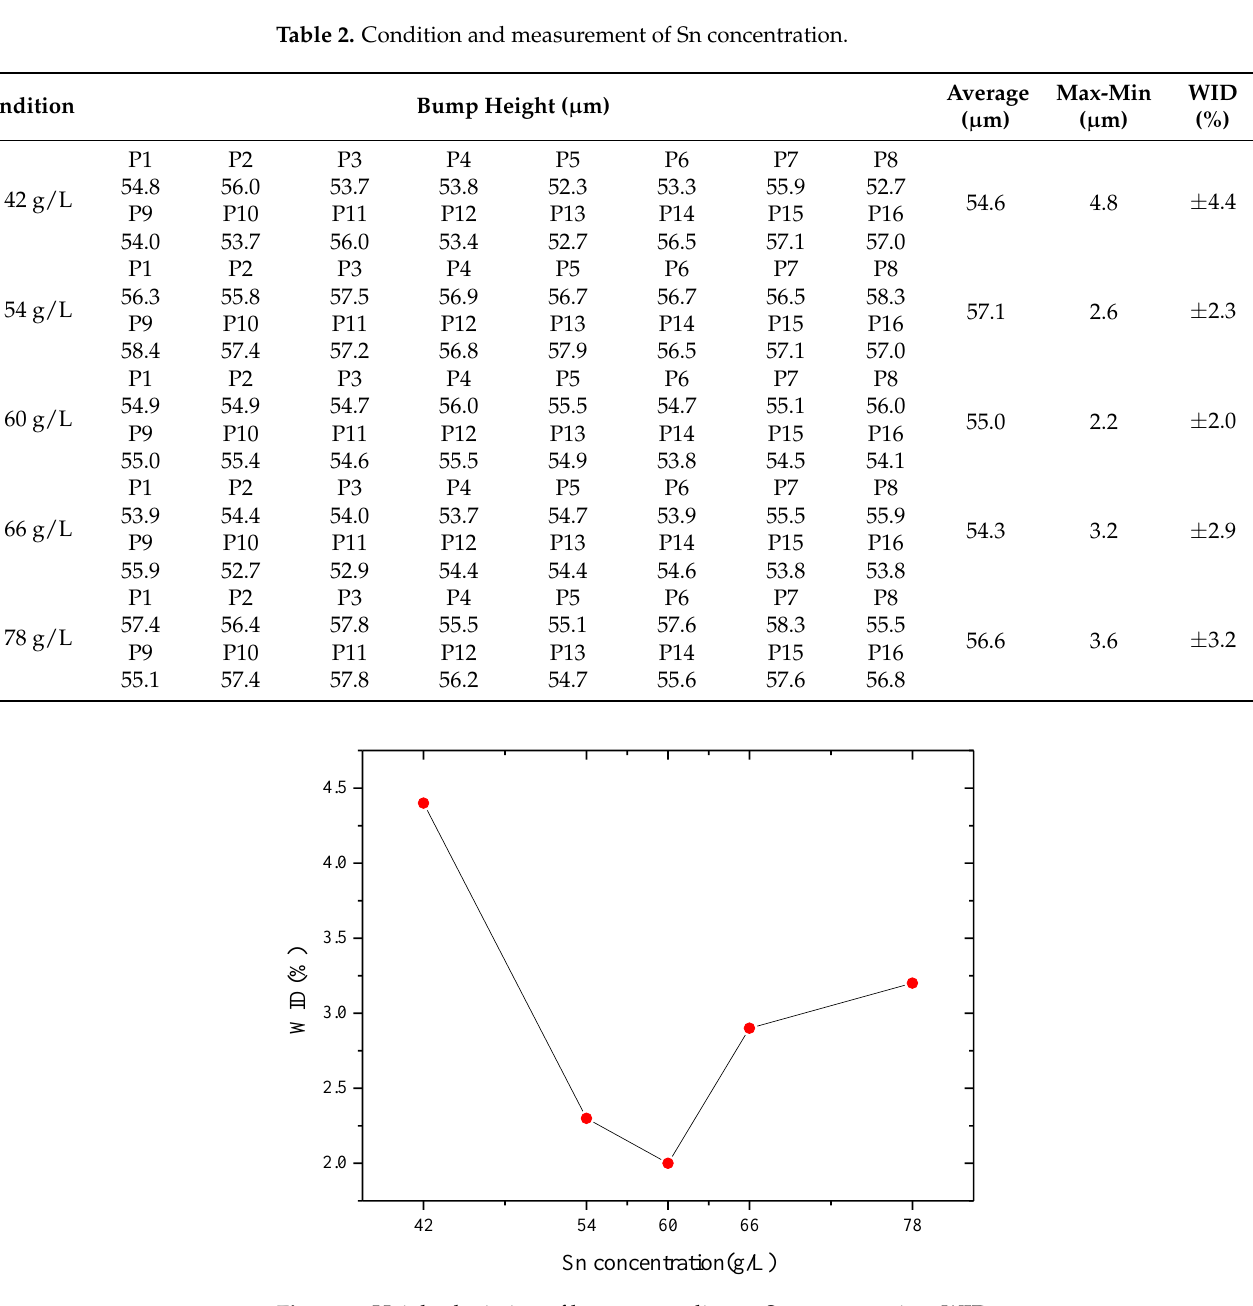
Table 3. Condition and measurement of additive.